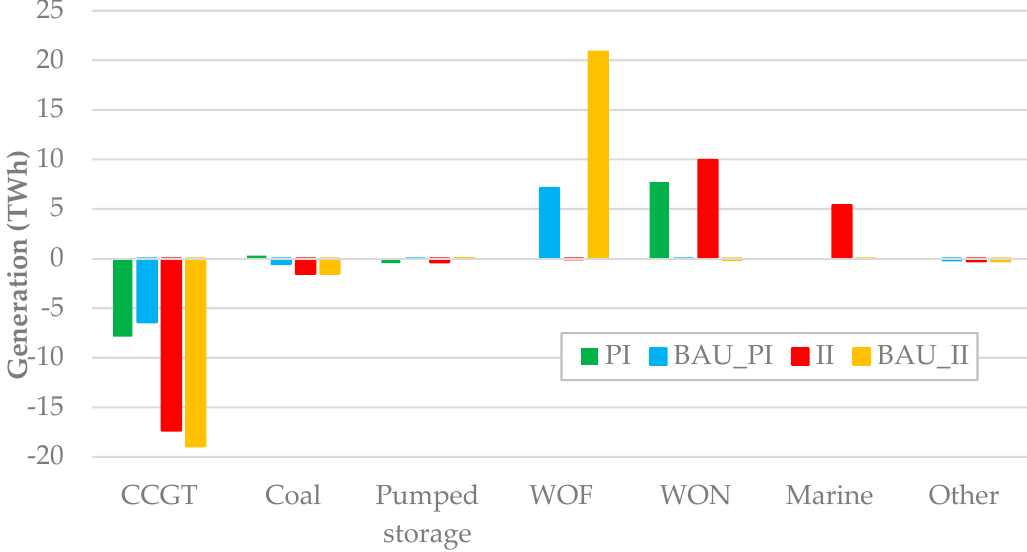
Figure 8. Difference of generation from the baseline BAU scenario. Biomass, nuclear, solar PV and hydro have been grouped in “Other” as they did not vary significantly between scenarios; wave and tidal have been grouped as “Marine”.